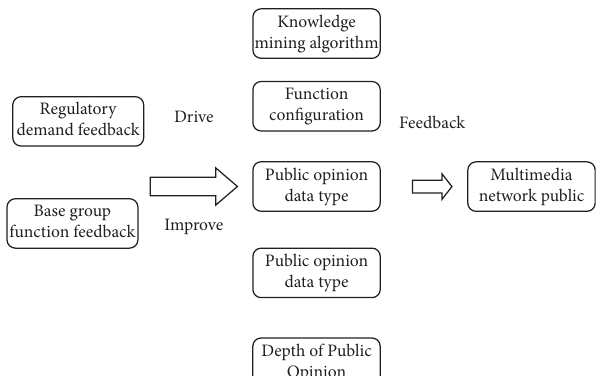
Figure 4: Multimedia network public opinion knowledge base group interoperability demand feedback mechanism.